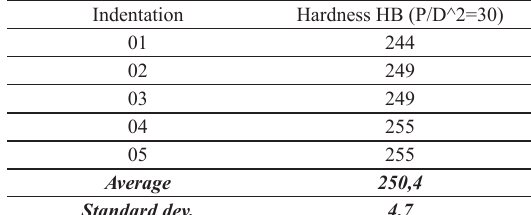
Table 3. Brinell hardness results X20CrMo13 stainless steel P1